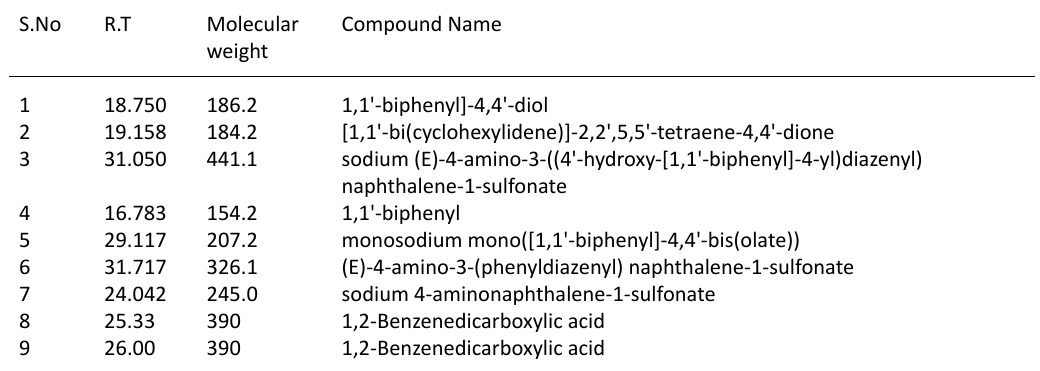
Table 3. GC-MS profile of Congo red-21 degradation products after laccase action S.No